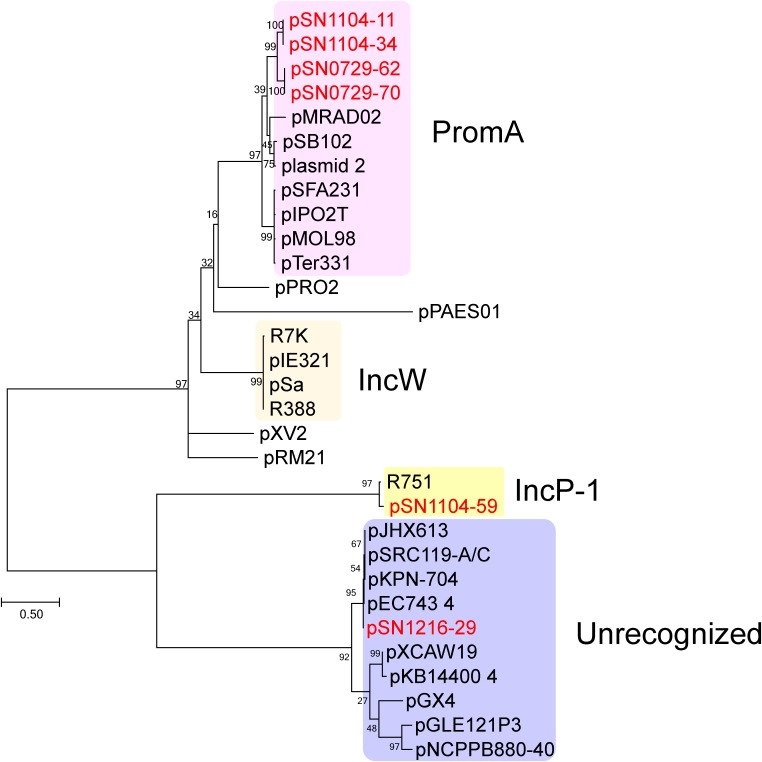
Phylogenetic analyses of captured plasmids and other related plasmids. A phylogenetic tree was constructed from amino acid sequences of a replication initiation protein (TrfA for IncP-1 plasmid, Rep or RepA for the others) by the maximum likelihood method with bootstrap percentages indicated at the nodes (Tamura-Nei model). A scale bar (0.50) shows substitutions per amino acid position. Previously known Inc groups are highlighted in colors, and a previously unrecognized plasmid group contains pSN1216-29. The accession numbers of the references are as follows: pPRO2 (CP000484), R7K (AM901564), pIE321 (EF633507), pSa (U30471), R388 (NC_028464), pXV2 (AF201825), pRM21 (U10426), pXCAW19 (NZ_CP009038), pKB14400_4 (CP014678), pGX4 (NZ_CP004364), pGLE121P3 (KC542383), and pNCPPB880-40 (JQ418534). Other references of PromA, IncP-1, and previously unrecognized plasmid groups are listed in Supplementary Table S5.